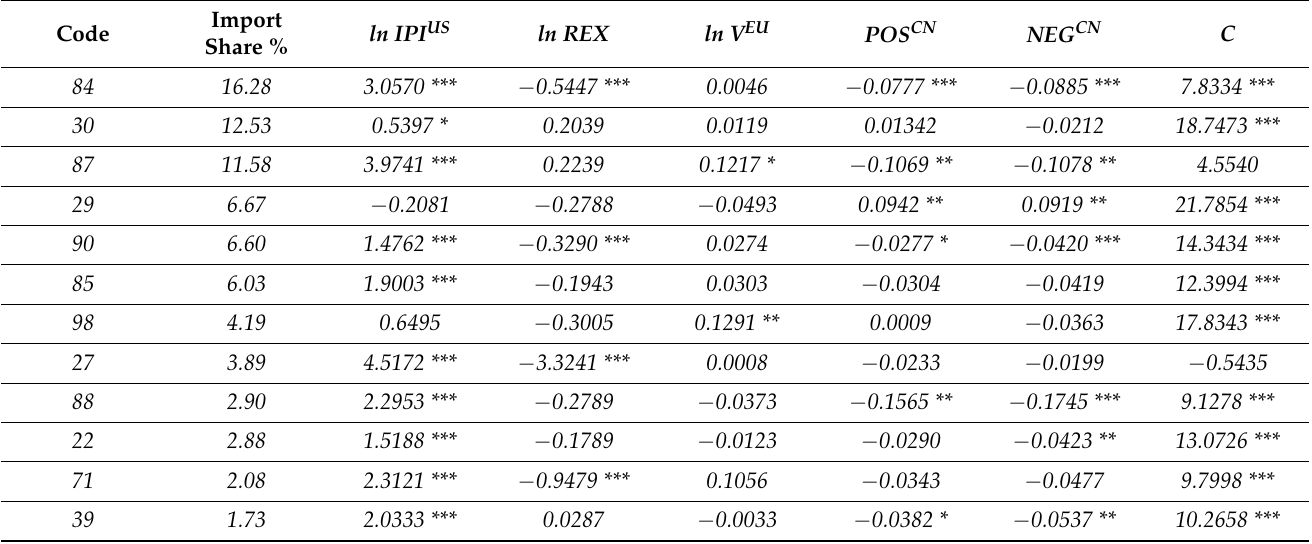
Table 11. Long-run coefficient estimates on US imports from the EU with third country effects using the nonlinear ARDL model (9).